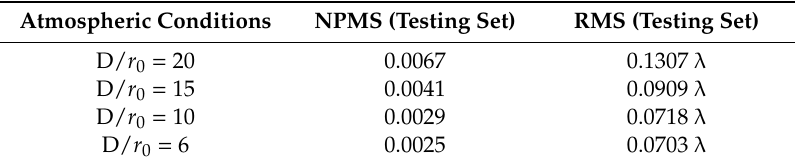
Table 1. Normalized-pixel-mean-square (NPMS) under di ff erent test sets of the reconstructed and simulated wavefront.